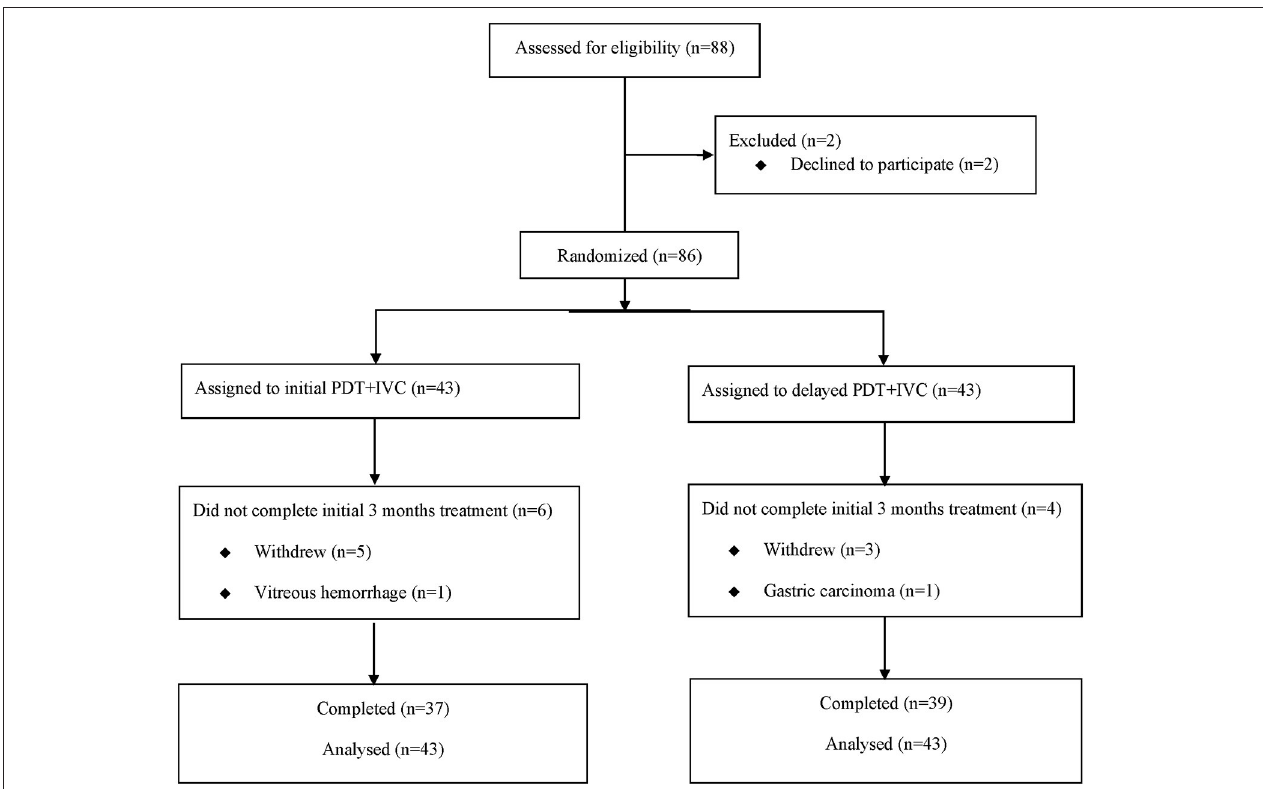
FIGURE 1 | Consolidated Standards of Reporting Trials (CONSORT) diagram showing progress of patients through the study. PDT, photodynamic therapy; IVC, intravitreal injection of